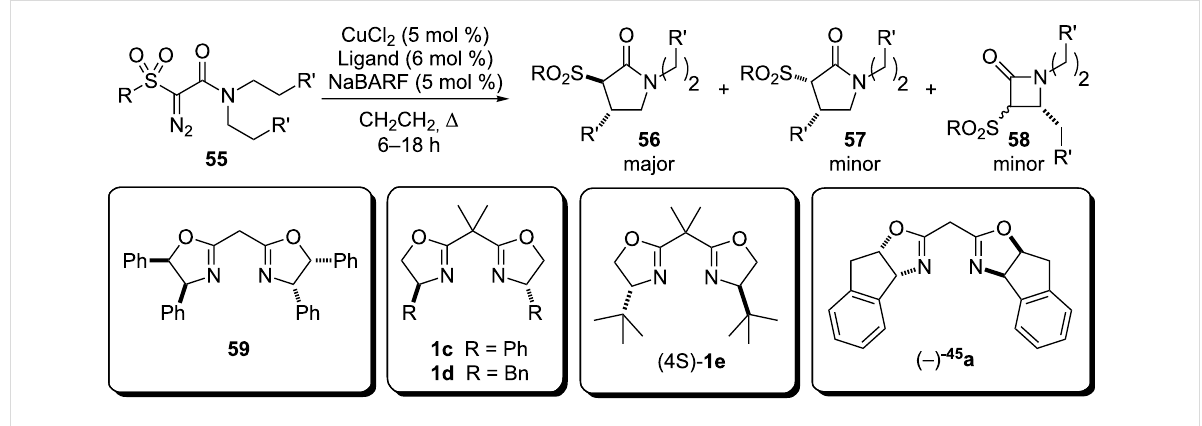
Scheme 11: Asymmetric insertion of copper carbenoids in C(sp 3 )–H bonds to prepare trans - γ